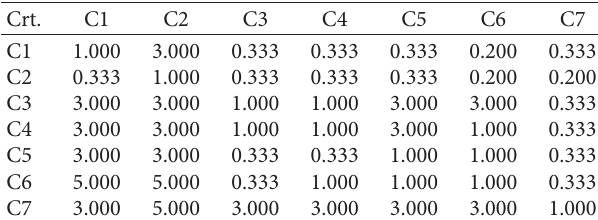
Table 3: Pairwise comparison